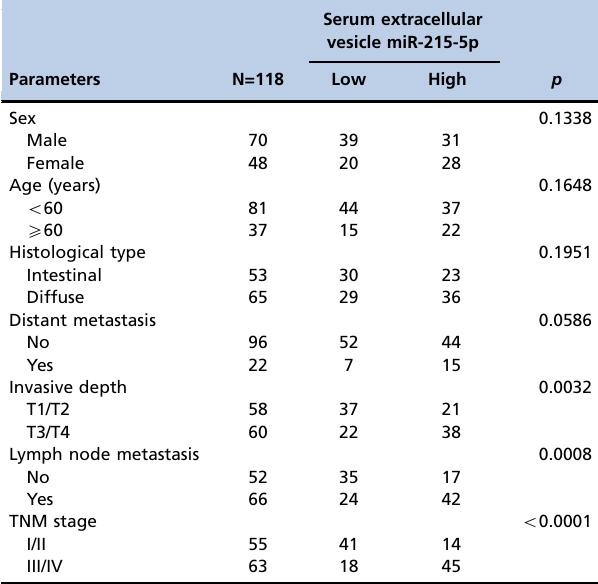
Serum extracellular vesicle miR-215-5p